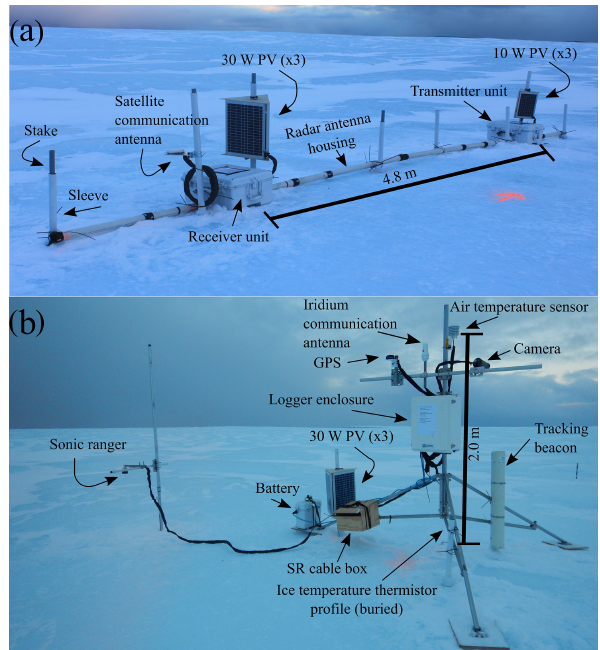
Figure 2. Instruments installed on PII-A-1-f on 20 October 2015. (a) Stationary ice-penetrating radar (sIPR) components deployed with antennas “in line” and attached to eight sleeves that slid over stake anchors. (b) Automatic weather station components, includ- ing a camera that acquired a weekly image of the sIPR and ablation stakes (not shown). The two systems were installed 30m apart on two small ridges at the location denoted in Fig. 1c. PV is photo- voltaic panel; SR is sonic